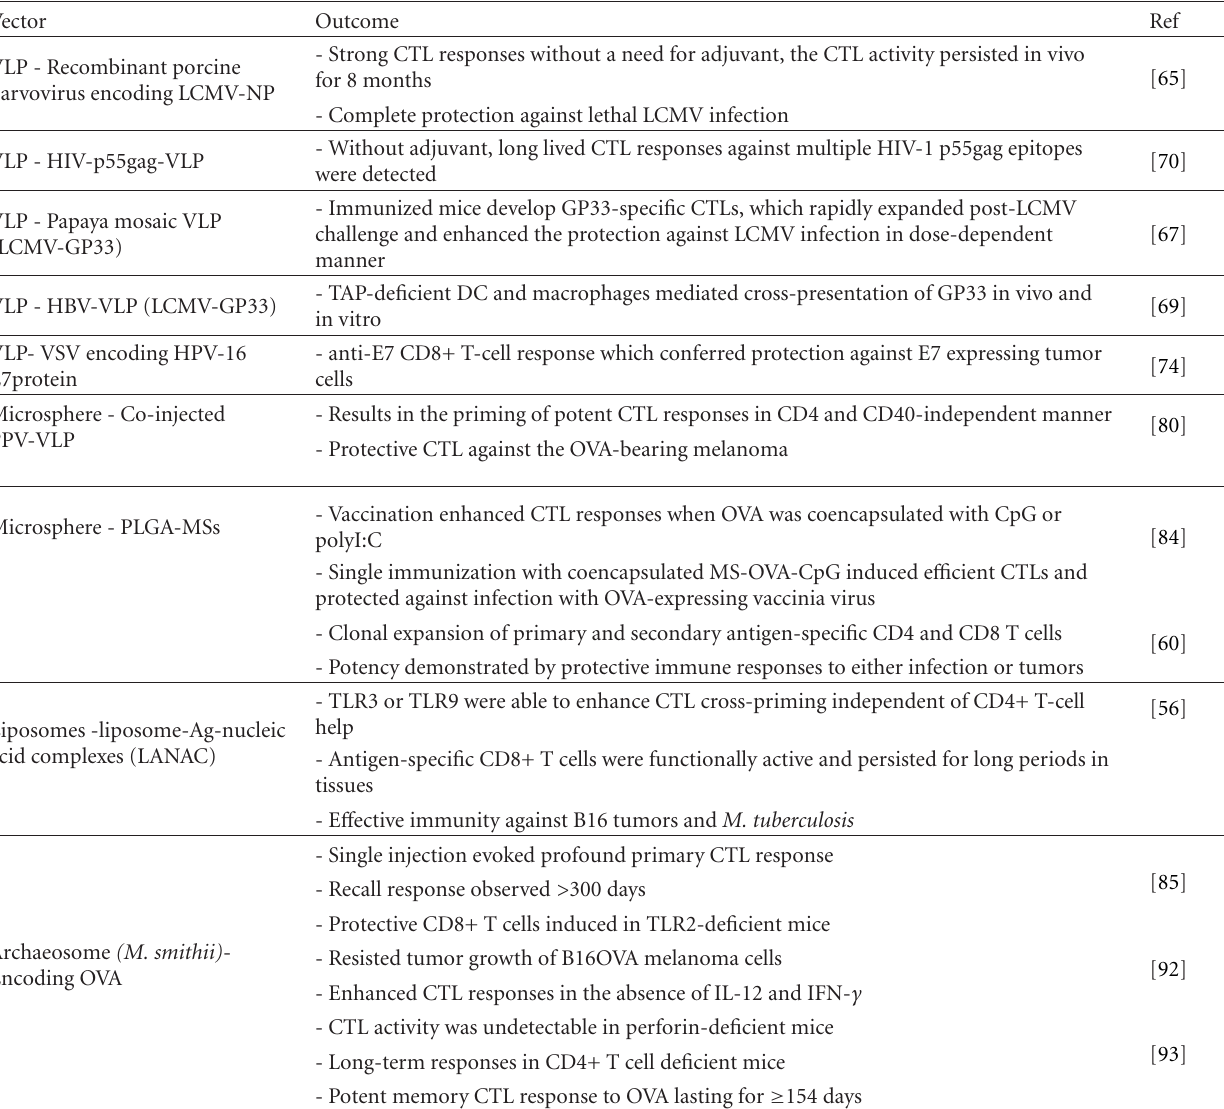
Table 1: Summary of the diverse vector approaches used for the generation of